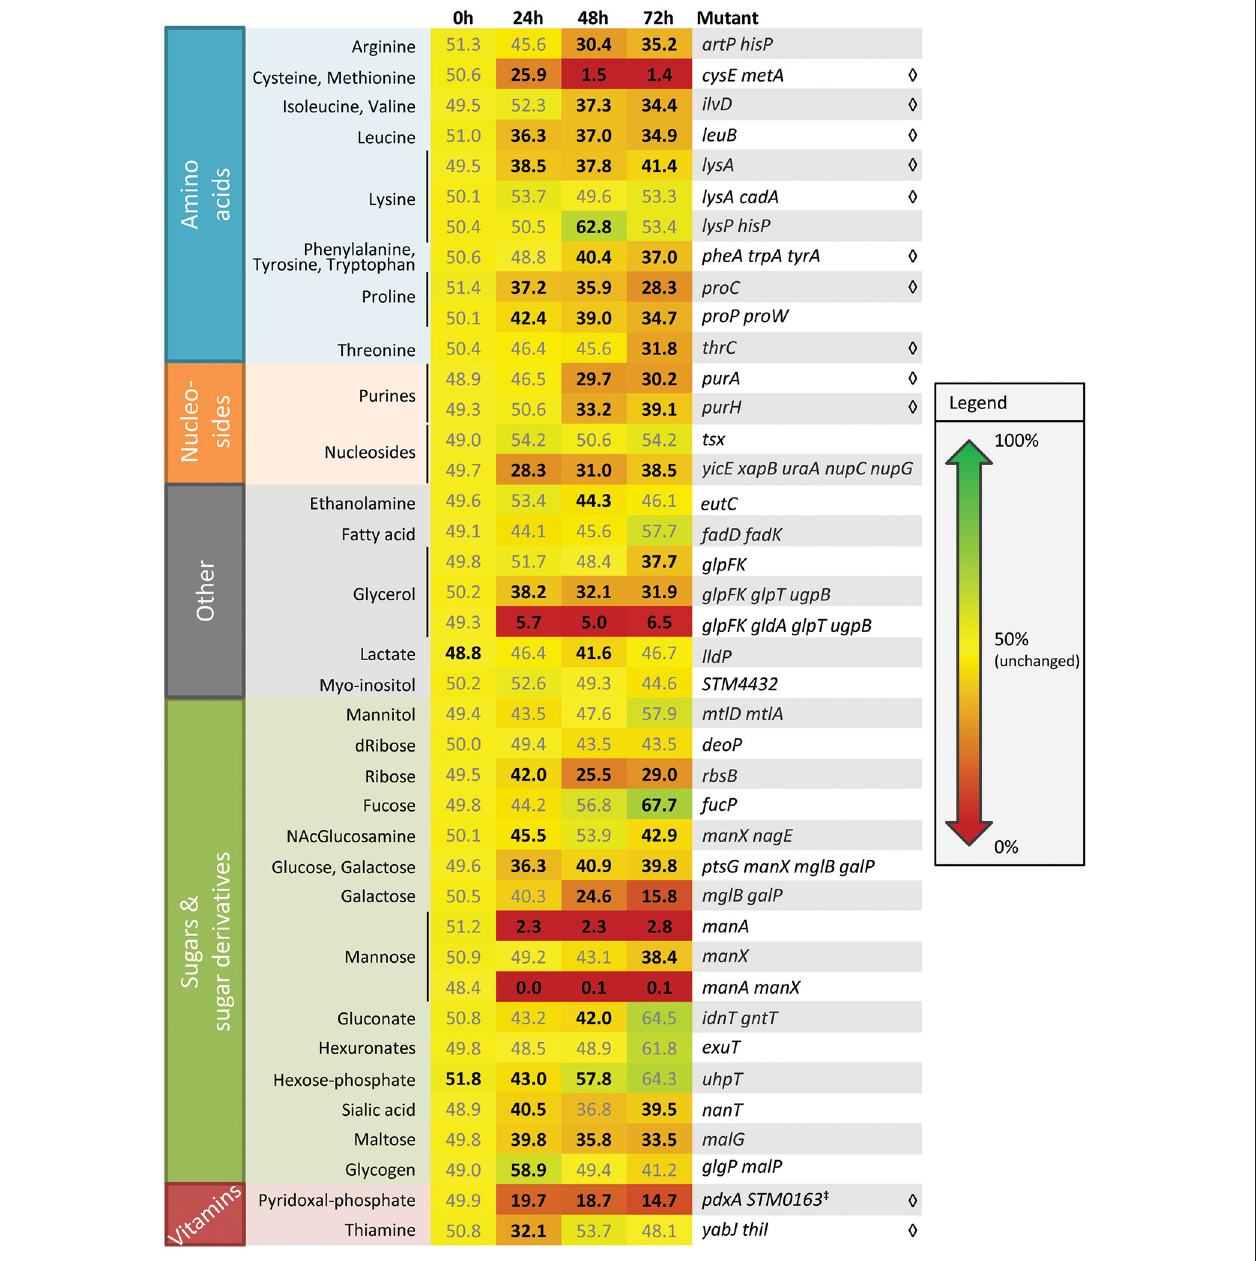
FIGURE 1 | Alfalfa seedling colonization fitness of Salmonella SL1344 metabolic mutants. Values indicate the percent of the total population comprised of mutant, following a 1:1 co-inoculation of WT and mutant. Cells containing these values are color coded as a heat map from 0 (red) to 100% (green) with yellow as 50%, i.e., equal to WT, for easy visualization of the data. Auxotrophic mutants are indicated by ♦ ; all other mutants lack genes for utilization of specific nutrients. The data shown are the means of three independent experiments with three replicates each. Bold values indicate a statistically significant difference from 50% ( t -test, p <